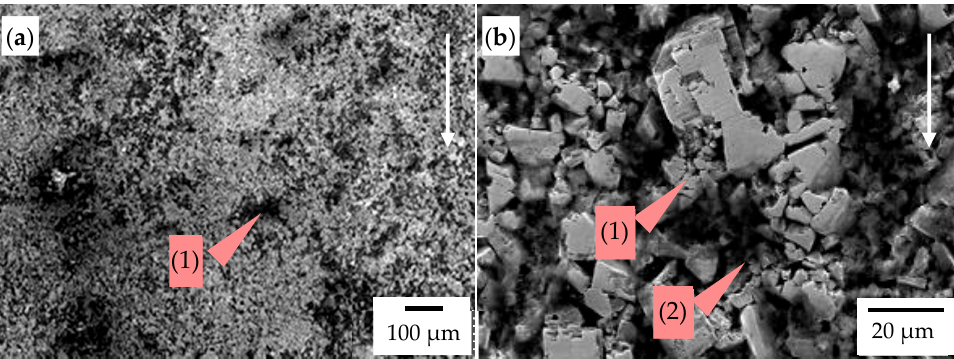
Figure 14. The worn surface of the cemented-carbide plate operating in the soil: chisel A, zone Z2 indicated in Figure 5; the white arrow presents the direction of the impact of soil particles. ( a ) Visible pits (1) caused by chipping out of WC grains from the cobalt matrix and ( b ) visible crushed WC grains (1) and pits (2). SEM, SE detector.